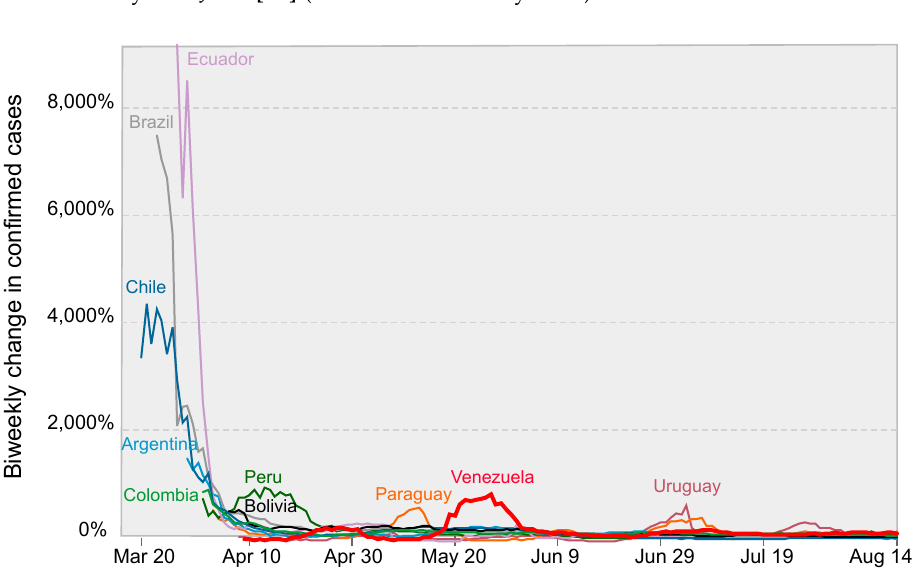
Figure A1. Biweekly changes in confirmed cases of COVID-19 per million people in South American countries. The highest biweekly changes indicate when the initial growth phase occurred in each country. Venezuela lagged behind most countries in the region. Figure adapted from Our World Data [32] (accessed on 30 May